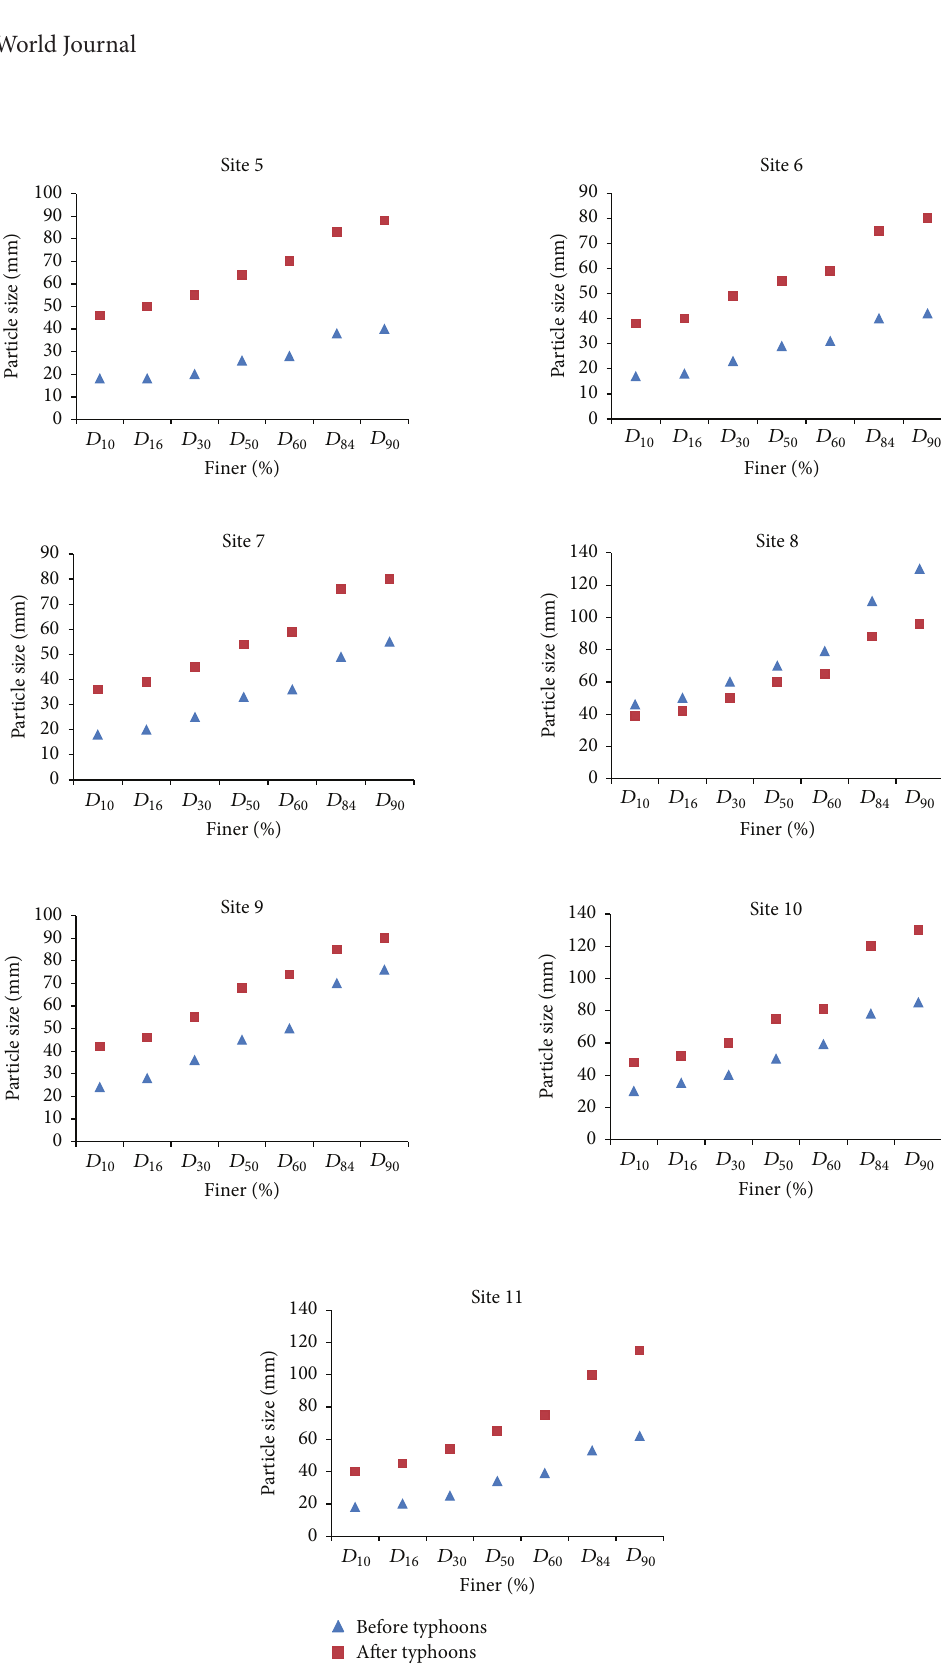
Figure 6: Grain size distribution before and after typhoon season using the grid